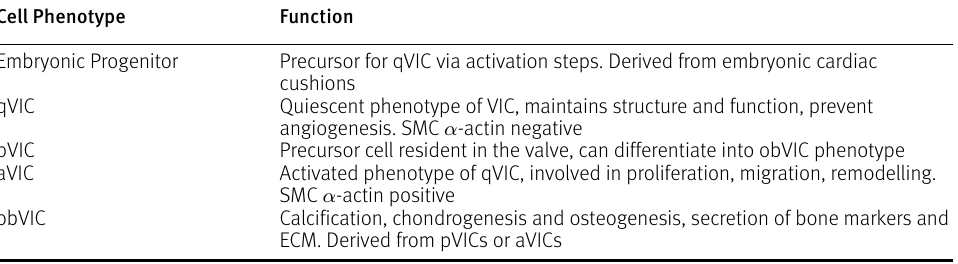
Table 2. Heart valve interstitial cell phenotypes.